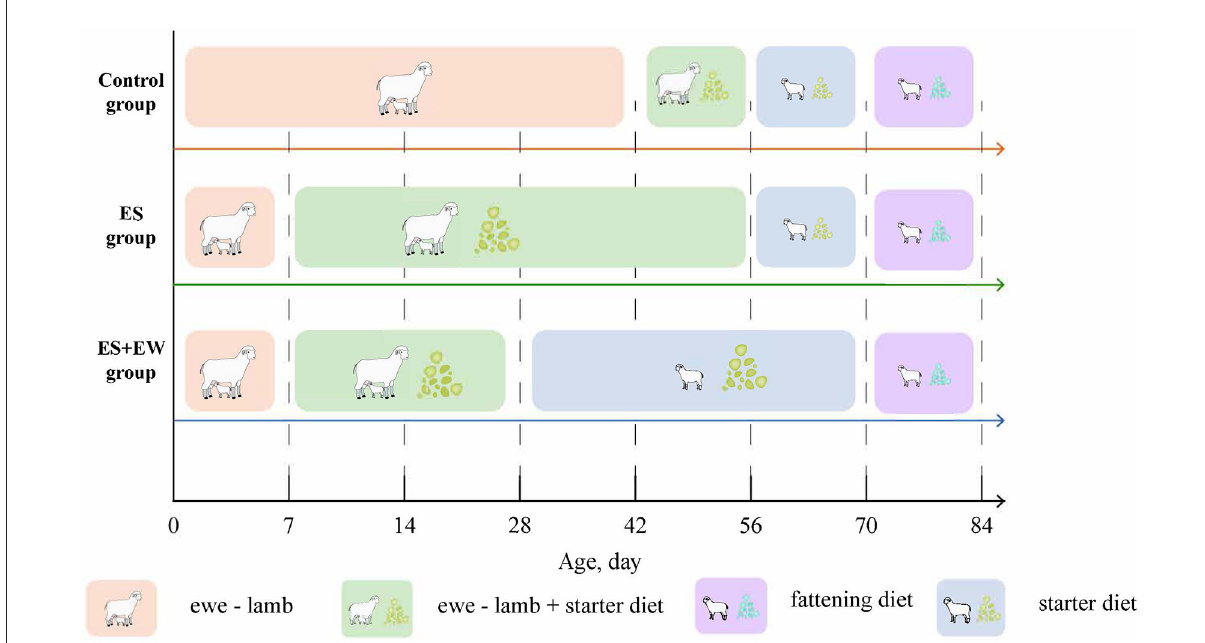
FIGURE1 Experimental design. Study design showing the time frame of the experiment and the treatment groups. The ewes of control group were fed according to the sheep farm procedure. At 42, 56, 70, and 84 days of age, six lambs were randomly selected from each treatment group, weighed, and